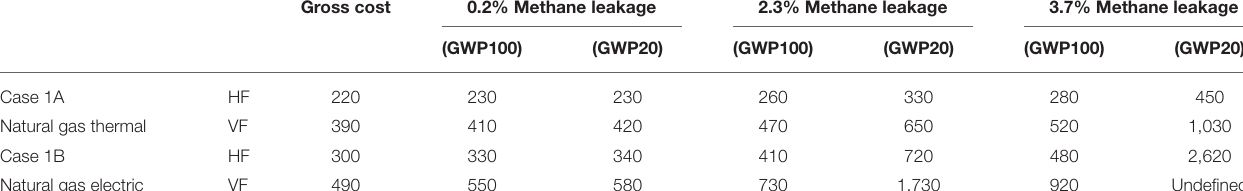
TABLE 4 | Gross and net costs of CO 2 removal, $/tCO 2 .